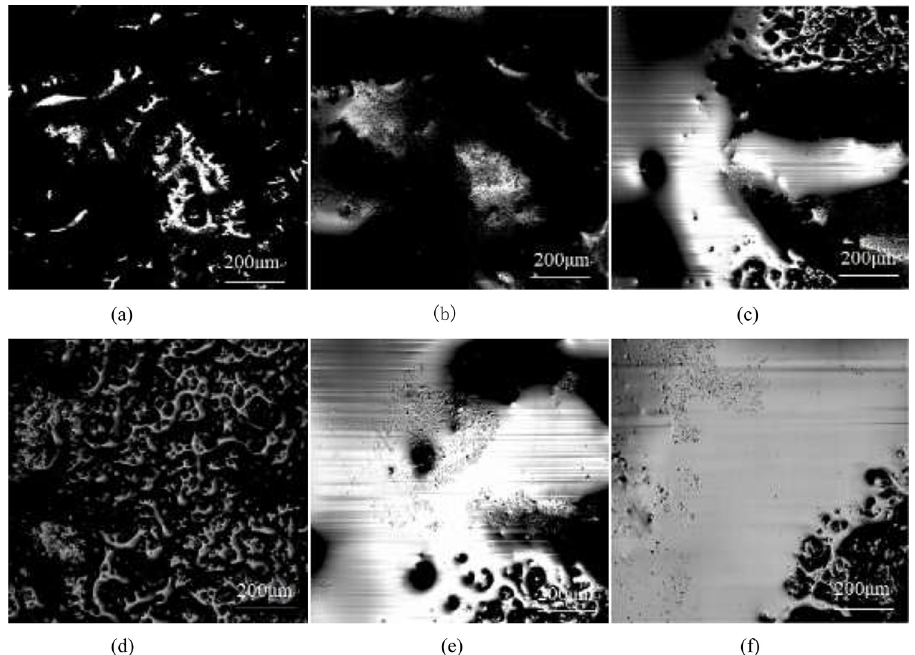
Figure 7: High temperature melting process of coal ash. ( a ) 1,423 K, ( b ) 1,473 K, ( c ) 1,523 K, ( d ) 1,573 K, ( e ) 1,623 K, and ( f ) 1,673